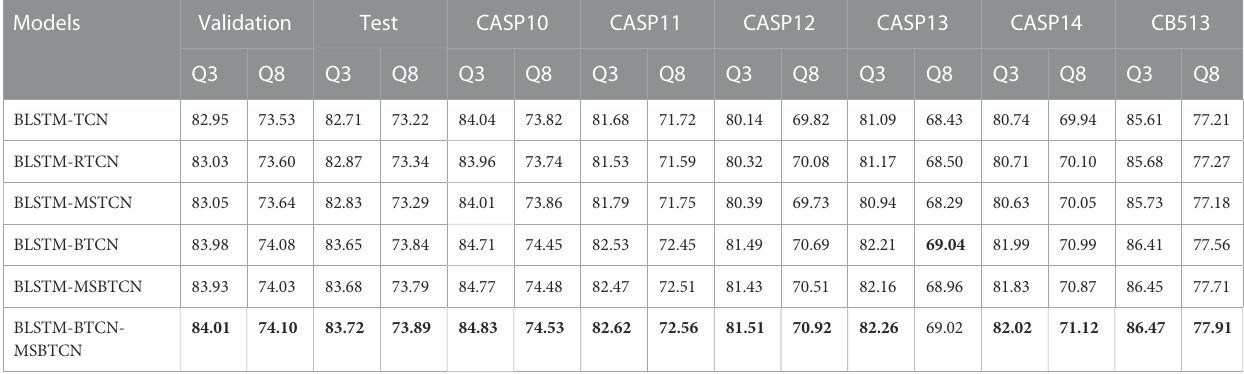
TABLE 4 Comparison of 3-state and 8-state PSSP performance of the proposed six models on eight datasets. Validation and Test represent the validation set and test set of CullPDB, respectively. The six models have the same feature extraction process and parameters. Bold indicates the best performance.